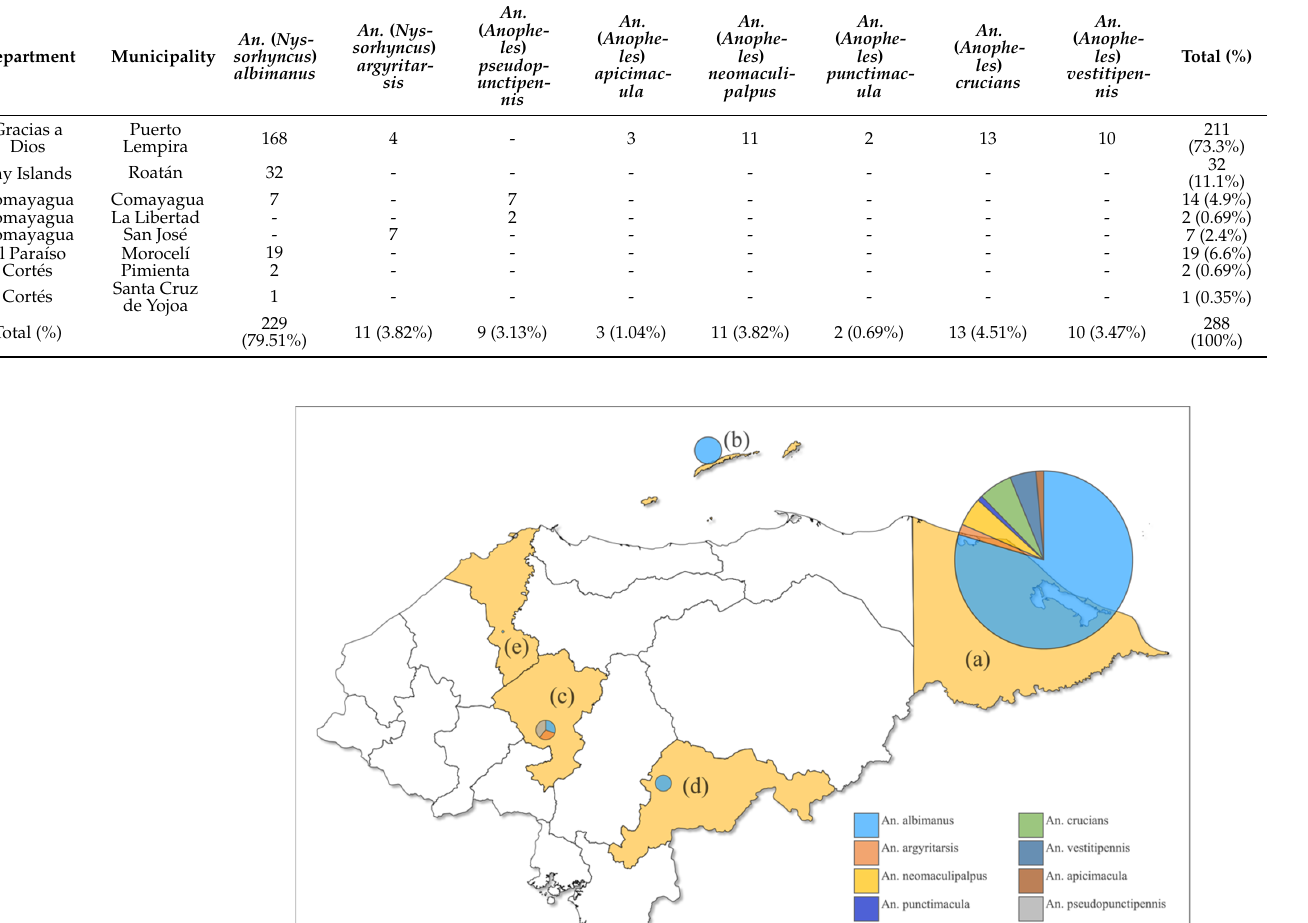
Table 2. Distribution and abundance of Anopheles species by geographical region.